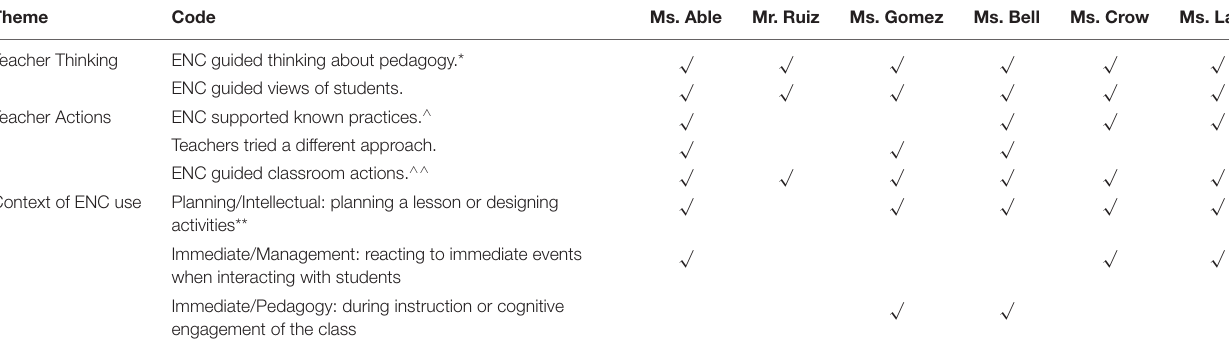
TABLE 3 | Cross-case comparison of how the teachers applied the